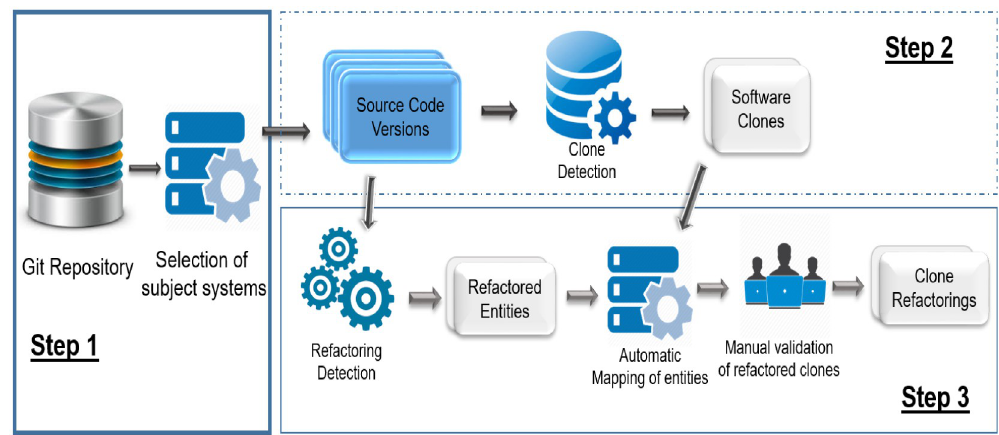
Fig 4. Experimental steps for clone refactoring evolution.